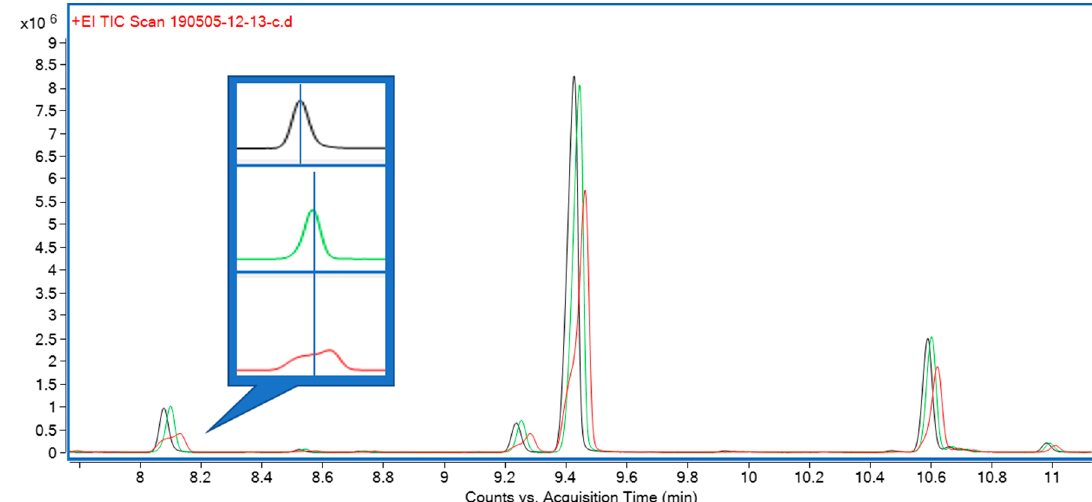
Figure 3. Comparison of peak shapes for early eluting compounds using three different injection solvents: hexane (black), ethyl acetate (green), isopropanol (red). Callout: enlarged detail of peaks at 8.05 min, separated, with vertical line through apex highlighting symmetry; solvents other than hexane cause undesirable peak shapes.